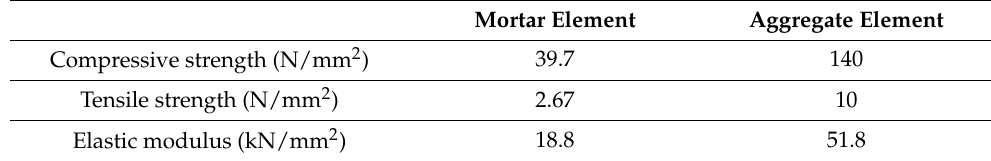
Table 4. Material property values in analysis model.